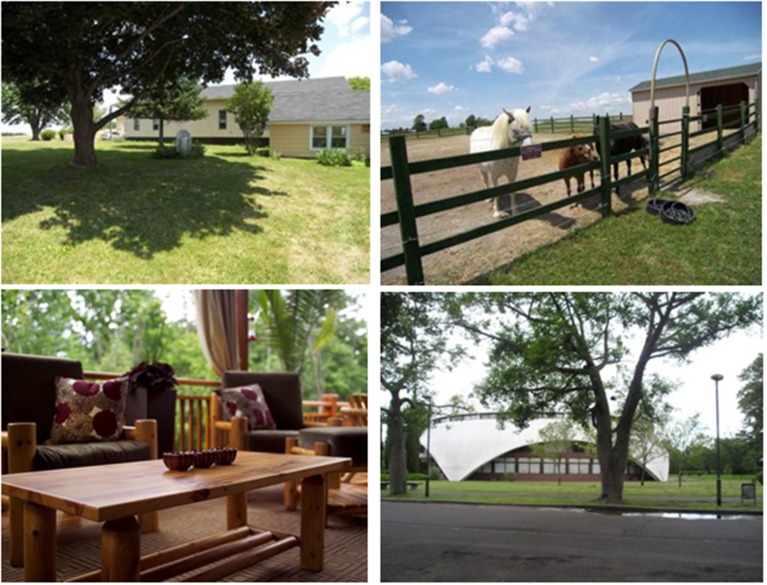
Four of the 28 photographs used as stimuli in Experiment 3. Infants viewed each photograph for 4 s and were allowed to look freely at each photograph during this time.